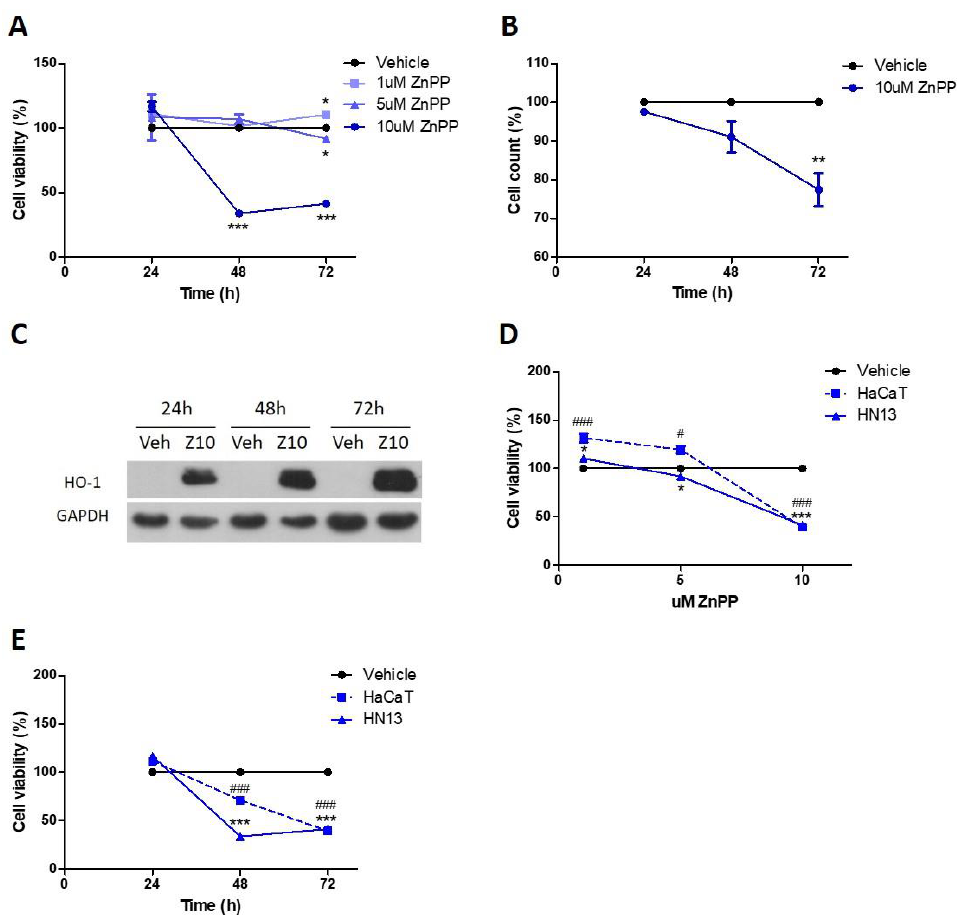
Figure 3. Pharmacological inhibition of HO-1 decreases cell viability of HN13 cells. ( A ) HN13 cell viability was evaluated after treatment with ZnPP (1, 5 and 10 uM) or its vehicle for 24, 48 and 72 h by crystal violet assay. ( B ) HN13 cell viability was evaluated after treatment with 10 uM ZnPP or its vehicle for 24, 48 and 72 h by manual cell count. ( C ) HO-1 protein expression was evaluated after treatment with 10 uM ZnPP or vehicle for 24 h to 72 h in HN13 cell line. HaCaT cell viability was evaluated after treatment with ( D ) ZnPP in dose-response assay at 72 h and ( E ) time-response assay using 10 uM concentration, comparing the effects with HN13 cells. The results are expressed as cell viability percentage = (ZnPP group x 100 / vehicle group). * p < 0.05, ** p < 0.01 and *** p < 0.001 with respect to the vehicle in HN13 cells. # p < 0.05 and ### p < 0.001 with respect to the vehicle in HaCaT cells.